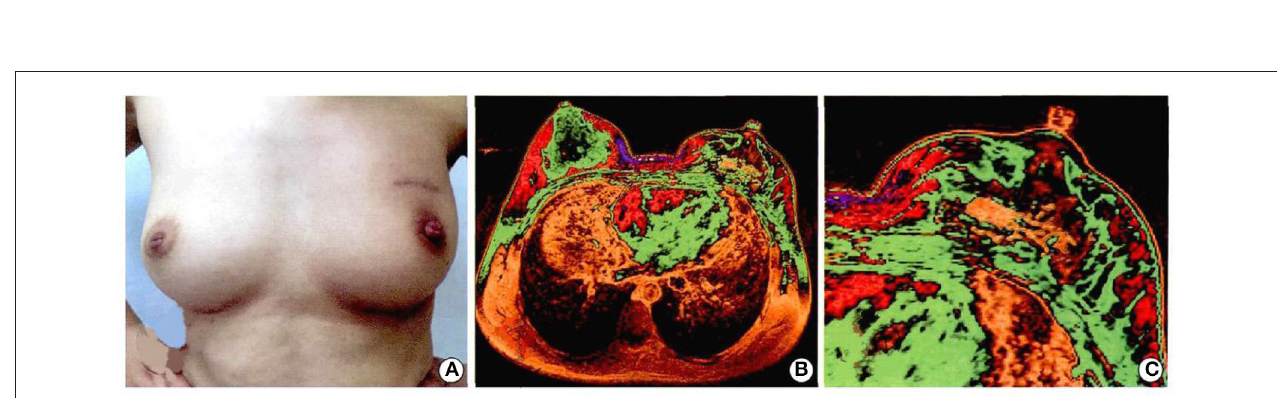
FIGURE 9 | Patients with breast cancer underwent left breast segment resection + 3D printing implant + axillary lymph nodes dissection. The breast appearance and follow-up of 9 months were as follows: (A) figure: cosmetic effect of breast; (B) magnetic resonance imaging of breast; (C) magnetic resonance imaging of implant. Written informed consent was obtained from the patient for the publication of any potentially identifiable images or data included in this article (26).